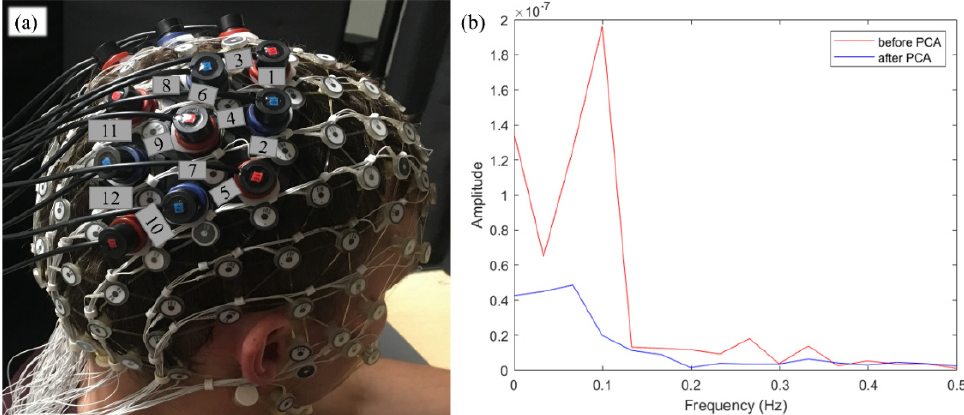
Figure 1. ( a ) NIRS optode arrangement. Red optodes: light sources; blue optodes: light detectors; numbers: channels formed by a source-detector pair; ( b ) power spectrum density analysis on hemodynamic signals before and after principle component analysis (PCA). Table 1. Brain regions measured with NIRS. Bold regions: selected regions of interest (ROI); Hem: hemisphere, Par: Num- ber of participants. The numbers in the ROI column are indices of the ROIs. Brain Region